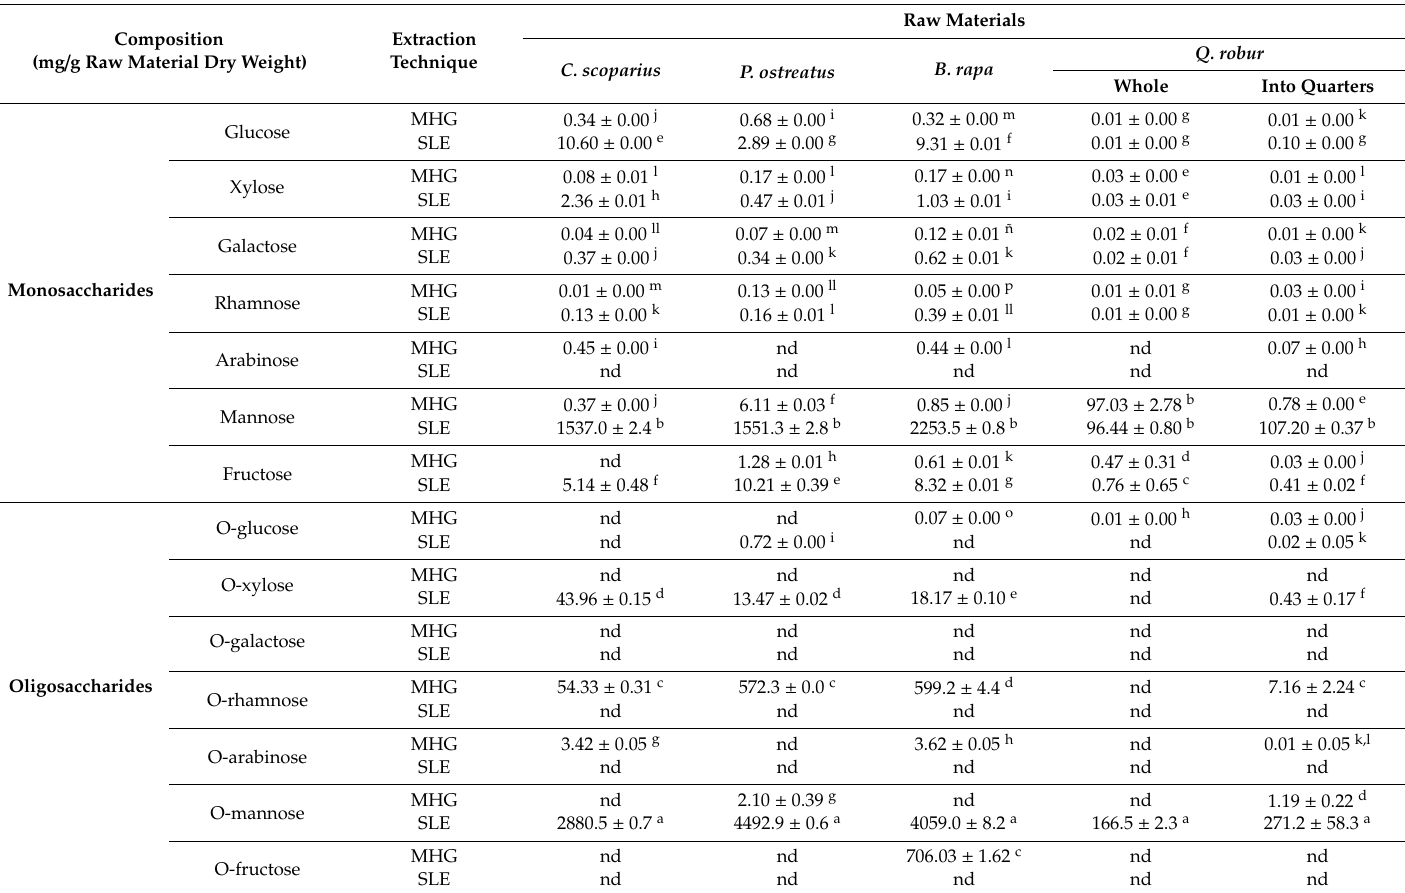
Table 1. Influence of the extraction at 100 W by MHG and solid liquid extraction from the di ff erent raw materials on the monosaccharide and oligosaccharide composition (mg / g raw material dry weight) of the liquid phase